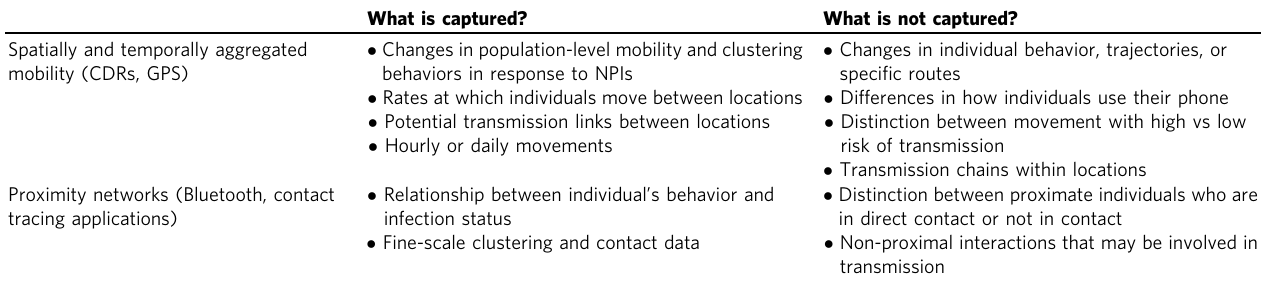
Table 2 Epidemiologically-relevant behaviors captured in mobile phone data. What is captured? What is not captured? Spatially and temporally aggregated mobility (CDRs,